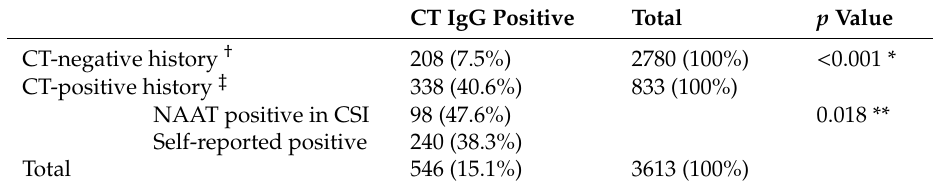
Table 2. CT IgG antibody status in women with a CT-positive history and a CT-negative